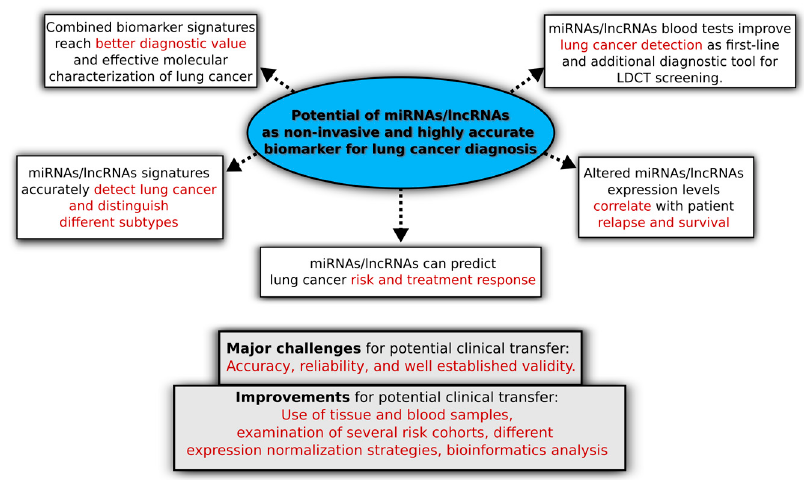
Figure 3. Schematic overview of key points of the potential of miRNAs and lncRNAs as non-invasive biomarker in lung cancer diagnosis. The Figure summarizes key points of the potential of miRNAs and lncRNAs as non-invasive biomarker in lung cancer diagnosis, current challenges and useful improvements for a clinical transfer in the future.